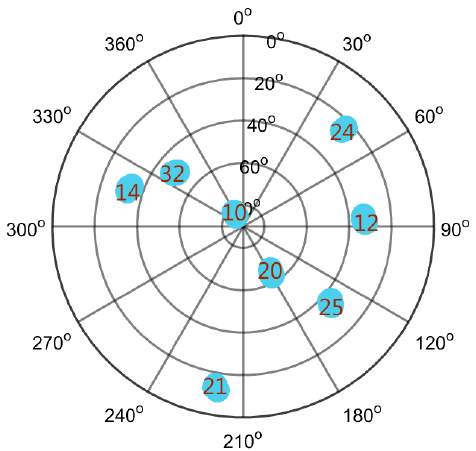
Figure 10. Sky plot of GPS satellites for the static field test.